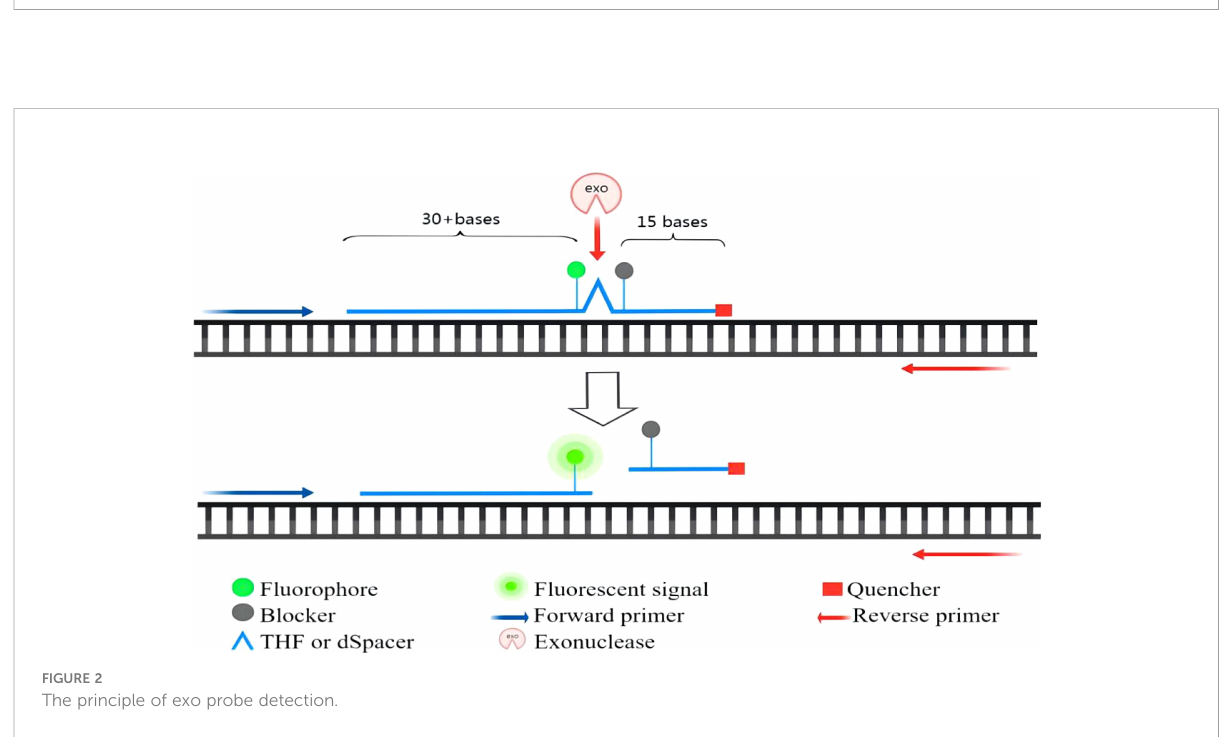
FIGURE 2 The principle of exo probe detection.